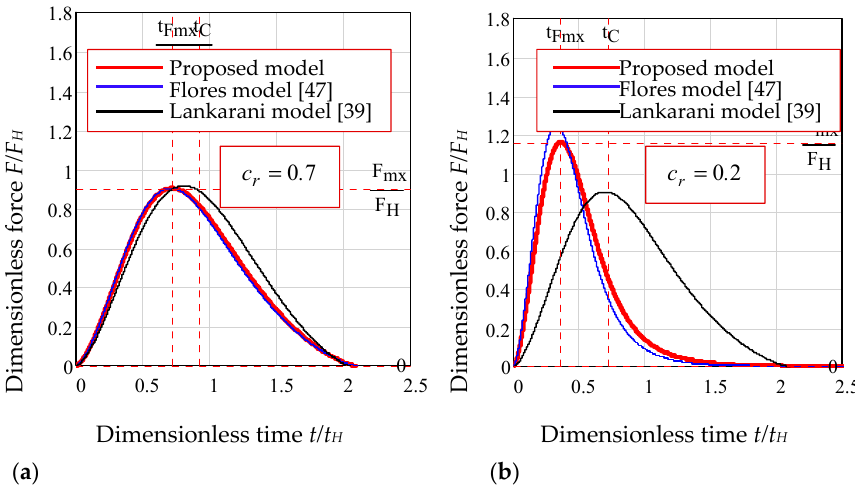
Figure 18. Velocity variation with time for the three models: ( a ) 𝑐 (cid:3045) = 0.7 and ( b ) 𝑐 (cid:3045) = 0.2 .